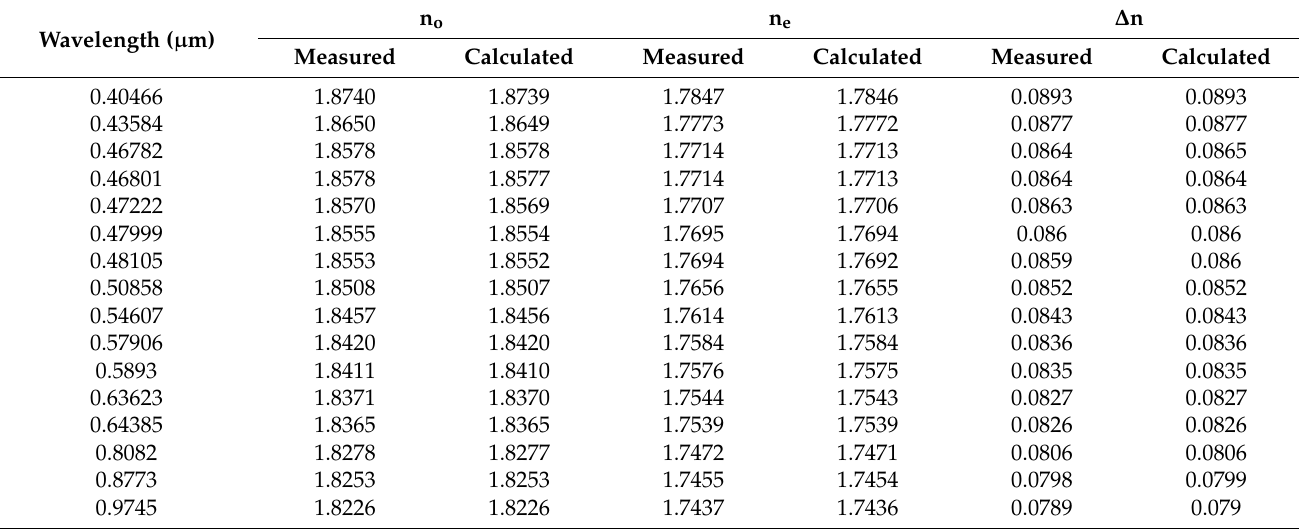
Table 3. LYSB crystal refractive indices. (Adapted with permission from ref. [13], copyright 2019 American Chemical Society).